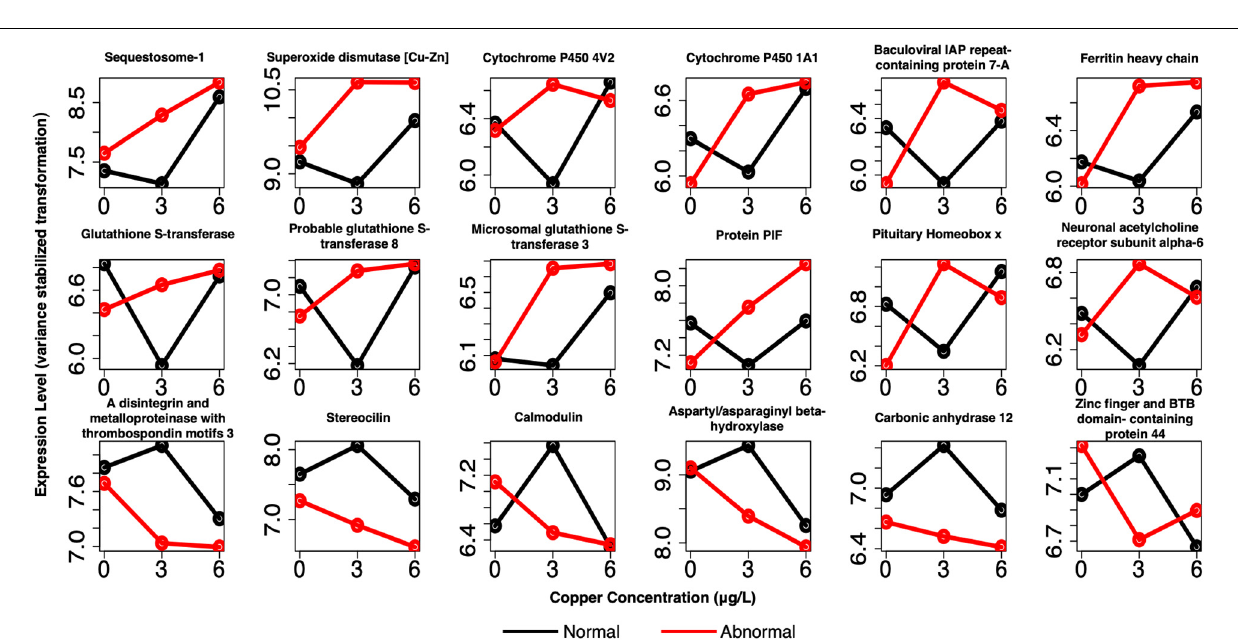
FIGURE 8 | Example profiles of pooled markers of exposure. Genes are related to oxidative stress, shell formation, cell adhesion, and other processes. Red lines depict expression of abnormal animals, and black lines depict expression of normal animals.